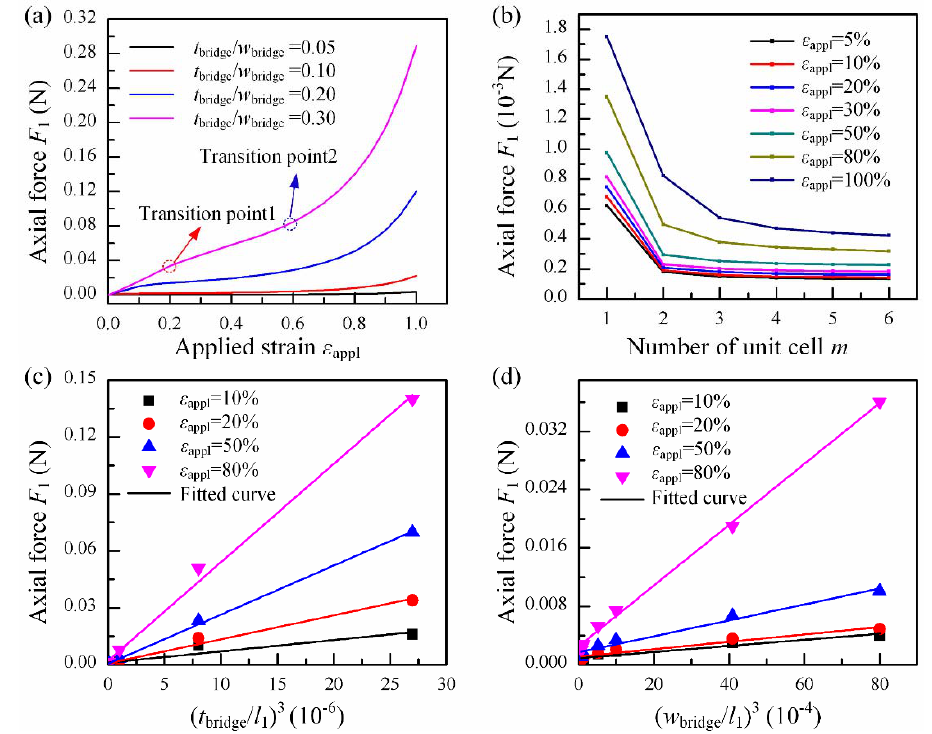
Figure 5. The axial force of a serpentine interconnect under stretching, obtained from the finite element analysis with different parameters: ( a ) applying strain, ( b ) wave numbers of bridge, ( c ) thickness of bridge, ( d ) width of bridge.